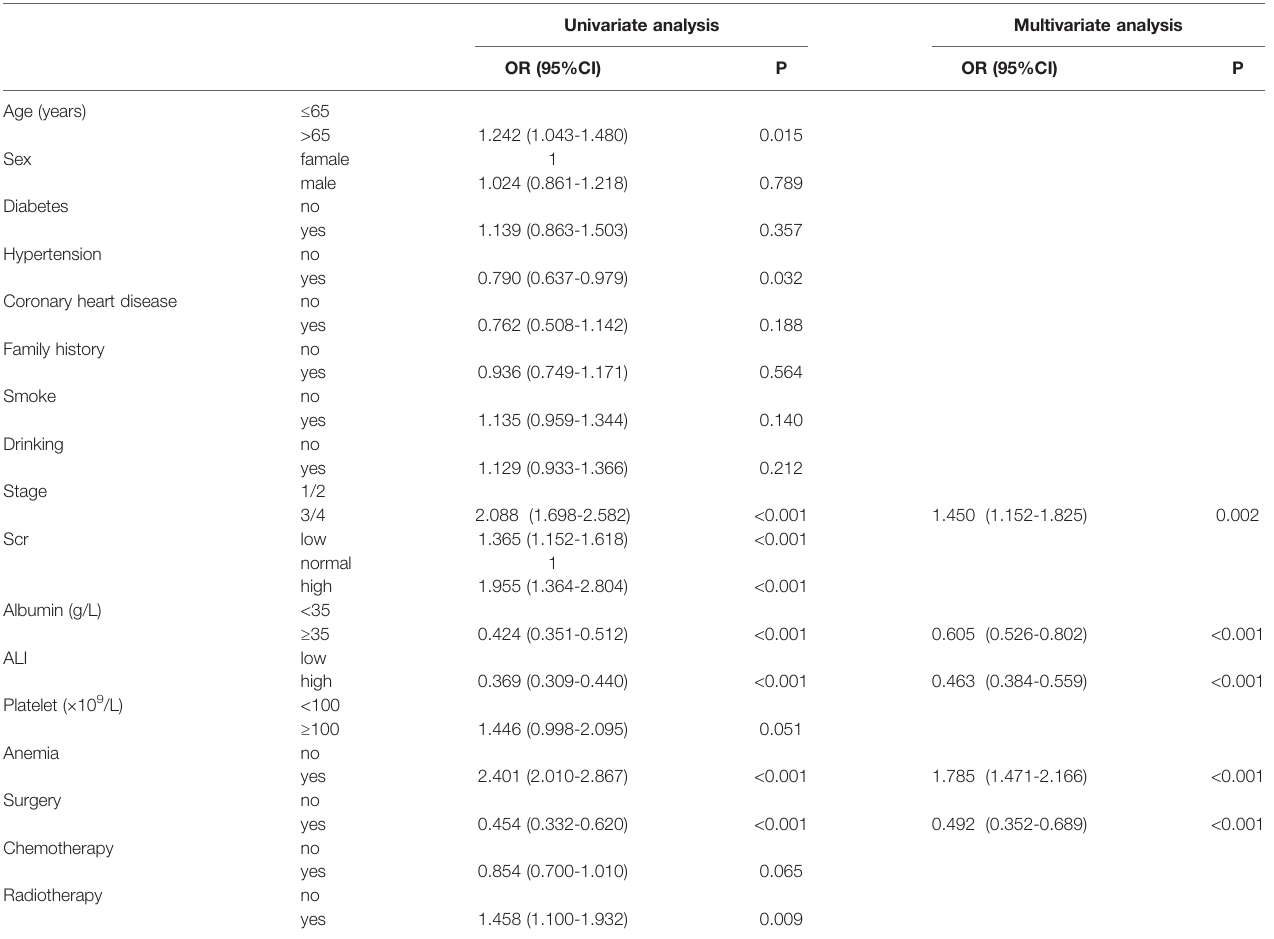
TABLE 2 | Logistic regression analysis of risk factors of cancer cachexia in patients with lung